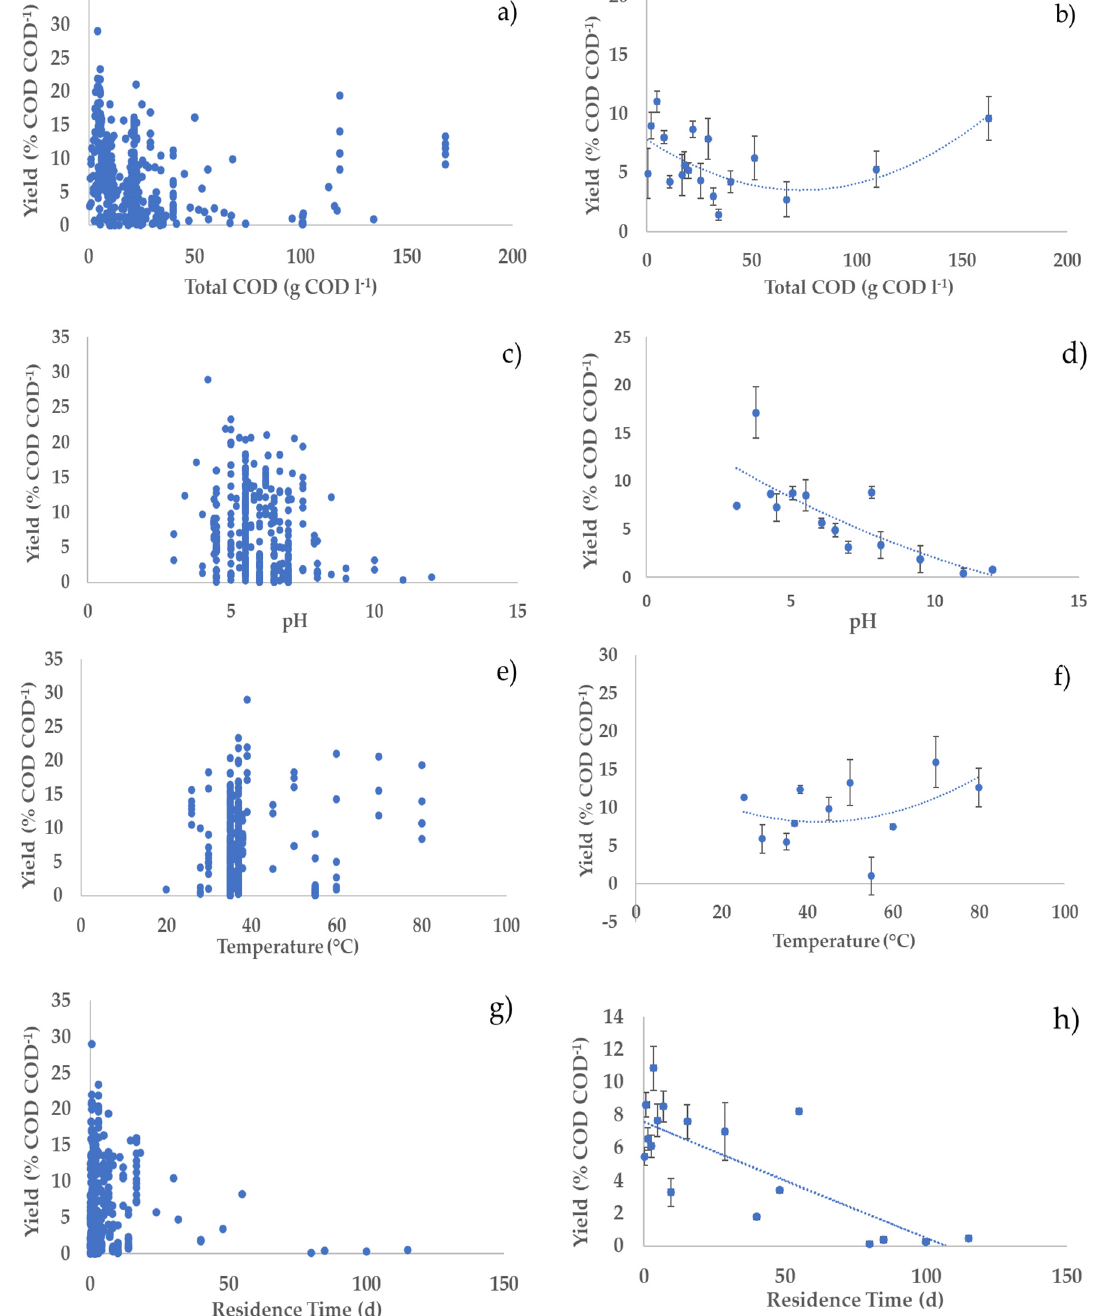
Figure 1. Relationships between hydrogen yield and operational parameters: ( a , c , e , g ) all considered experiments; ( b , d , f , h ) average values of experiments in each narrow range (width maximum 20%) of the operating parameters (error bars indicate the standard error) with second-order polynomial curve. The polynomial curve is only used to visualise the general trend, without any statistical significance.